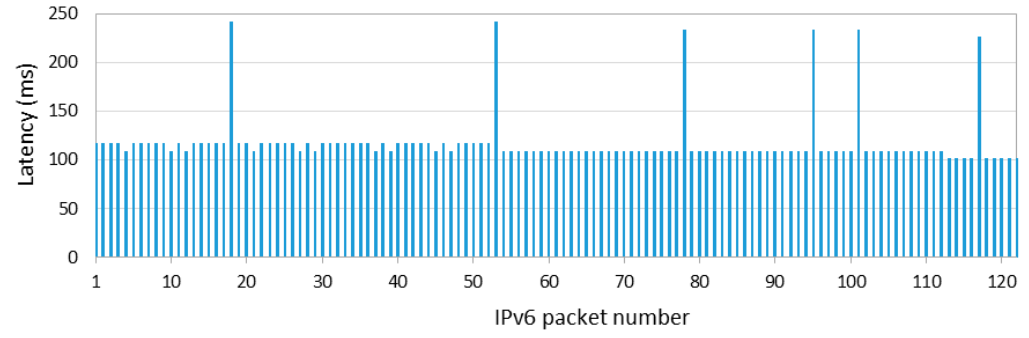
Figure 6. One-hop IPv6 packet delivery latency when the sender (the 6LR in our testbed) only relays the packet received from the 6LN to the 6LBR (for connInterval = 125 ms).